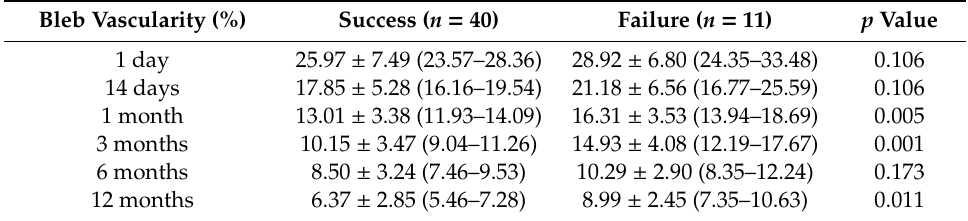
Table 2. Vascularity of the filtering bleb after trabeculectomy in relation to surgical success rates 12 months postoperatively. Data presented as mean ± SD (95% CI).